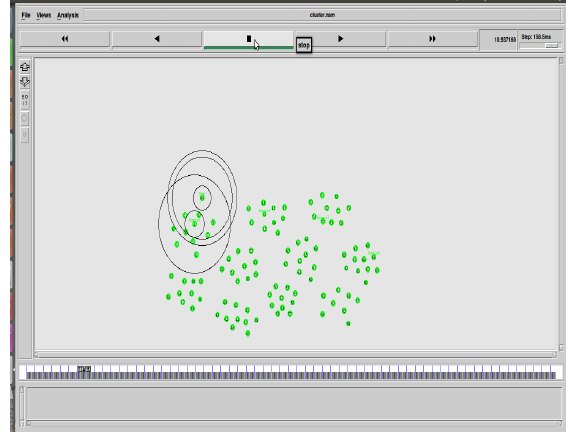
Figure 8. A mobile ad-hoc